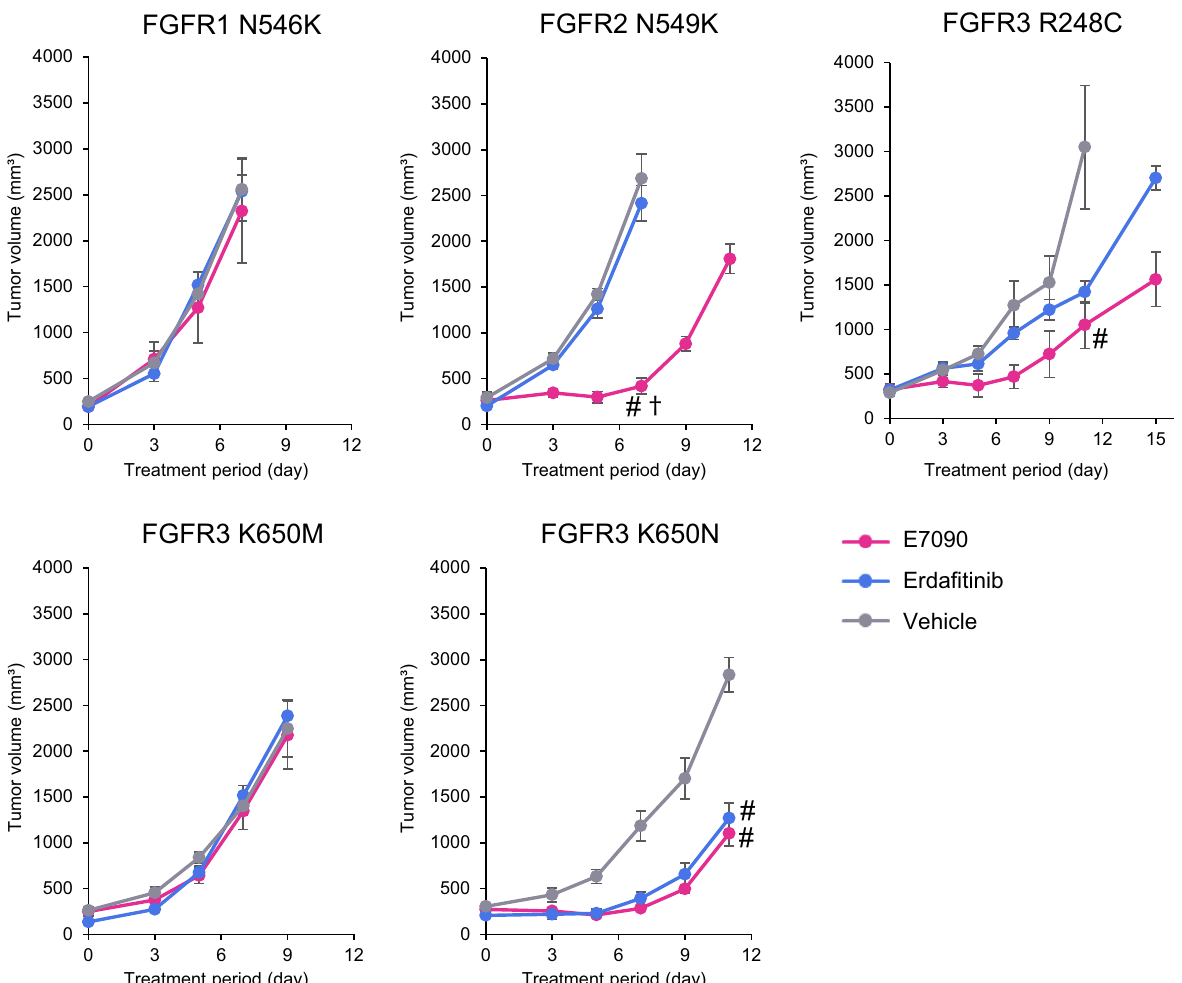
Fig. 5 Inhibition of tumor growth in vivo by FGFR-targeted drugs. 3T3 mouse fi broblasts expressing FGFR variants were subcutaneously injected into 6-week-old female nude mice. The mice were treated with erda fi tinib (12.5 mg/kg body weight), E7090 (25 mg/kg body weight), or vehicle control once daily by oral gavage ( n = 5 mice for each group). # p < 0.05 vs. vehicle; † p < 0.05 vs. erda fi tinib; error bars,